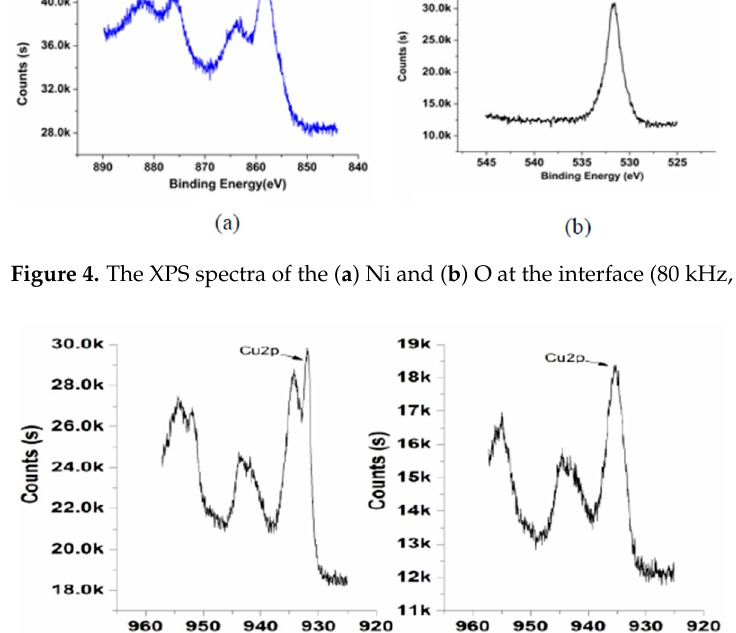
Figure 4. The XPS spectra of the ( a ) Ni and ( b ) O at the interface (80 kHz, 100 W).